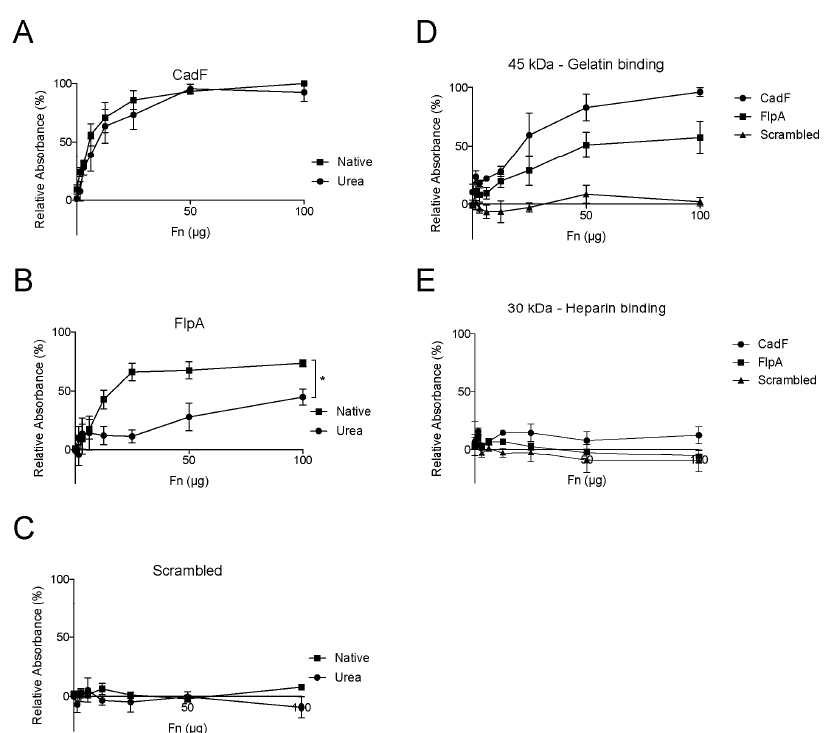
Figure 7. Peptides derived from the binding domains of CadF and FlpA bind to folded fibronectin (FN), specifically in the 45 kDa gelatin-binding region. ELISAs were done using peptides derived from the FN-binding domains of CadF, FlpA, and a scrambled peptide to determine the ability to bind to FN in the presence or absence of 4 M urea. Wells were coated with the peptide, and a range of FN concentrations were added to the wells. ( A ) The CadF peptide binds to FN in a saturation-dependent manner in both the presence and absence of urea. ( B ) The FlpA peptide only binds FN in a saturation-dependent manner in the absence of urea. ( C ) The scrambled peptide, which is a randomized stretch of amino acids drawn from the CadF and FlpA peptides, did not bind to FN. ( D ) Neither the CadF, FlpA, nor scrambled peptide bound to the 30 kDa fragment of FN. ( E ) Both the CadF and FlpA peptides, but not the scrambled peptide, bound to the 45 kDa fragment of FN. The data are presented as a percentage of relative absorbance, where zero is the assay background derived from bovine serum albumin (BSA)-coated wells, and 100% is the highest value in the given assay. The data represents the mean ± the standard deviation of three independent biological replicates. A summary statistic was calculated from the area under the curve (AUC) in the presence and absence of urea and compared using a paired Student’s t -test. The asterisk indicates that the AUC was significantly different in the presence and absence of urea (* p < 0.05).